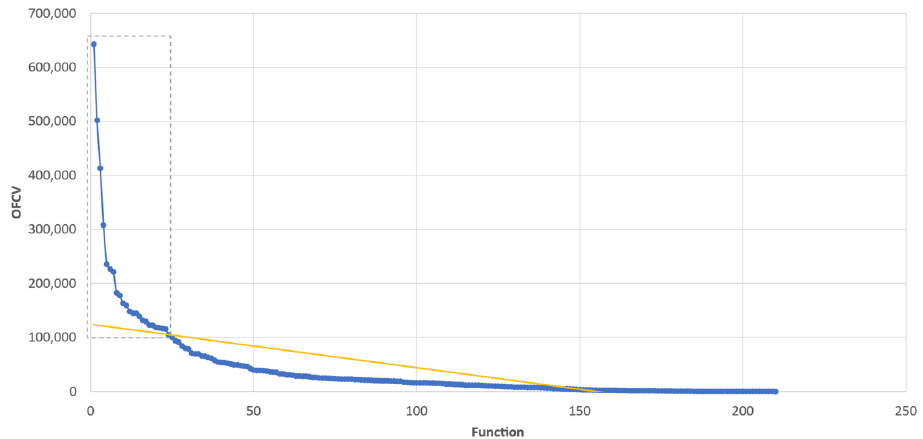
Figure 6. Scree test and regression curve using OFCV for the human driver. The first 23 functions are highlighted by a grey dashed box indicating risk functions.